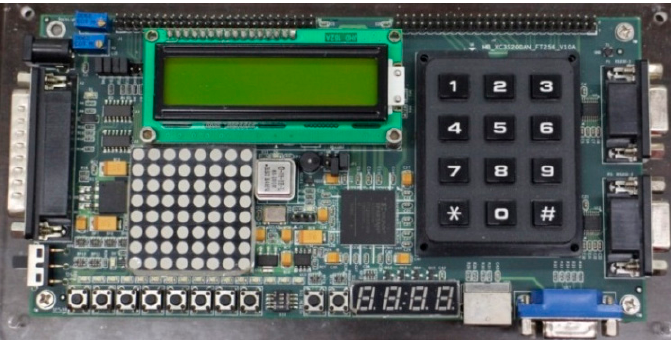
Figure 11. Photograph of the test FPGA board.